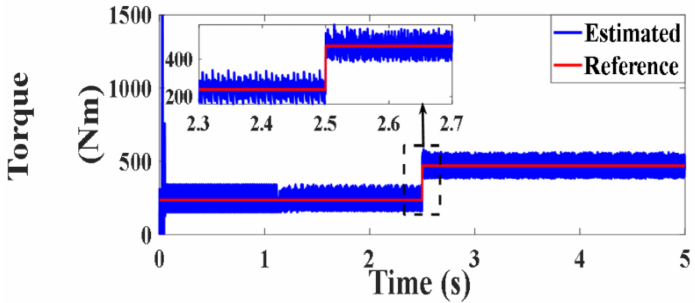
Figure 61. Developed torque under PVC (Nm).